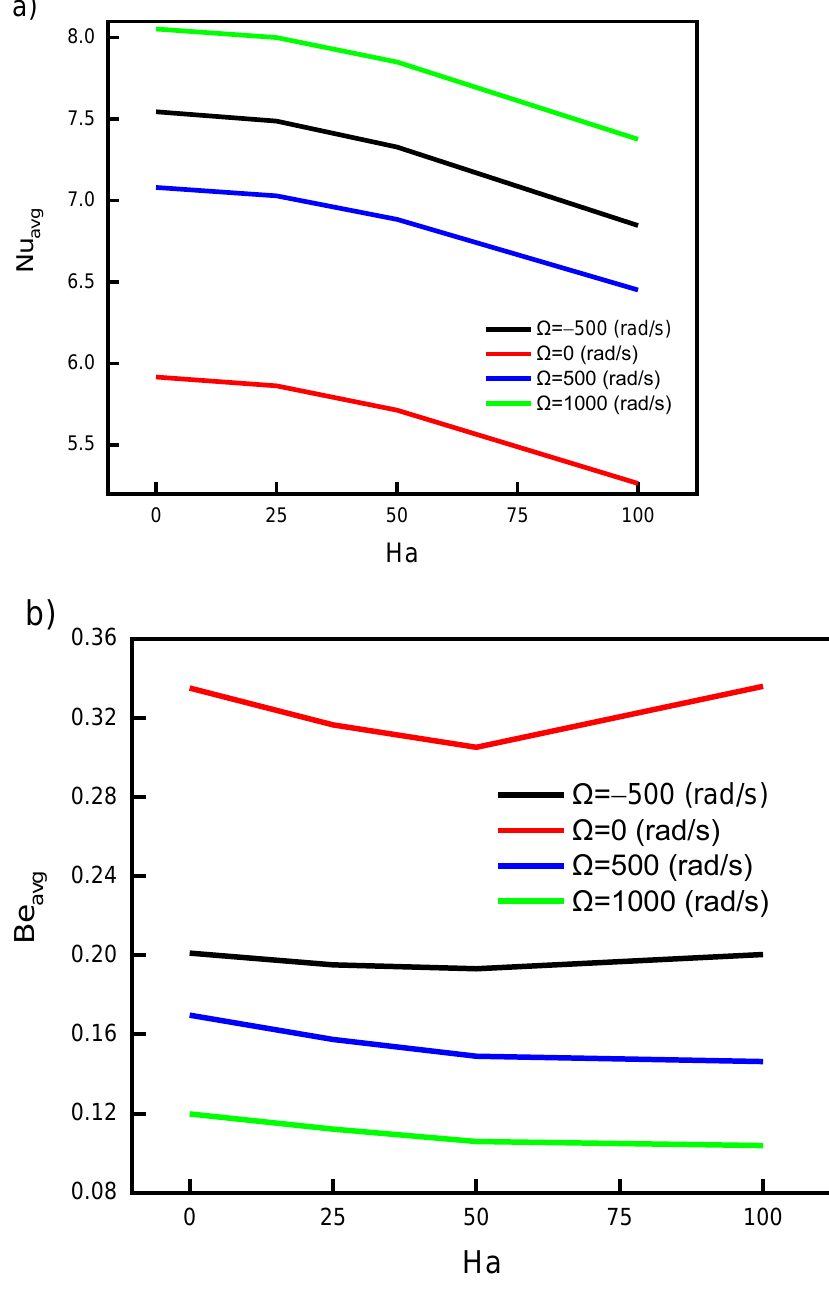
Figure 8. Impact of Hartmann number on ( a ) Nu avg and ( b ) Be avg for various cylinder rotating